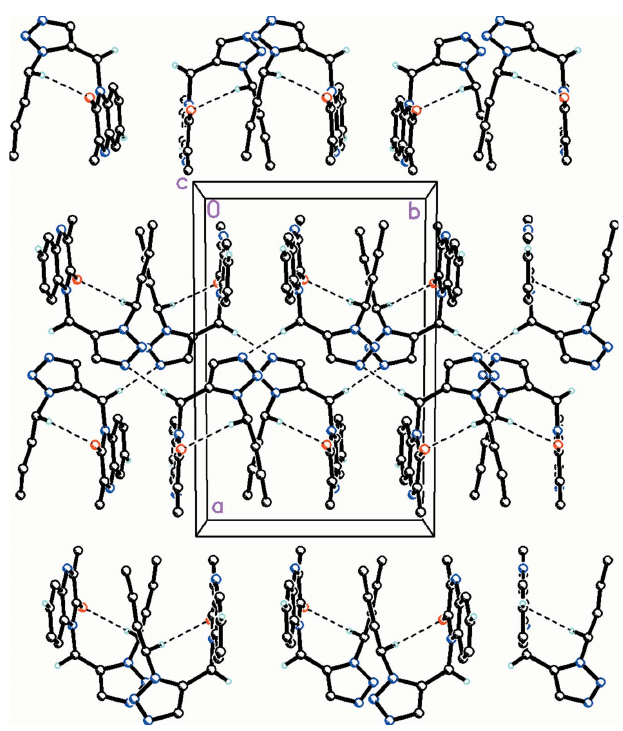
Figure 2 A partial view along the c axis of the crystal packing. Dashed lines indicate both weak C—H (cid:3)(cid:3)(cid:3) O, C—H (cid:3)(cid:3)(cid:3) N intermolecular and C—H (cid:3)(cid:3)(cid:3) O intramolecular interactions. Atoms not involved in the hydrogen-bonding interactions have been omitted for clarity.